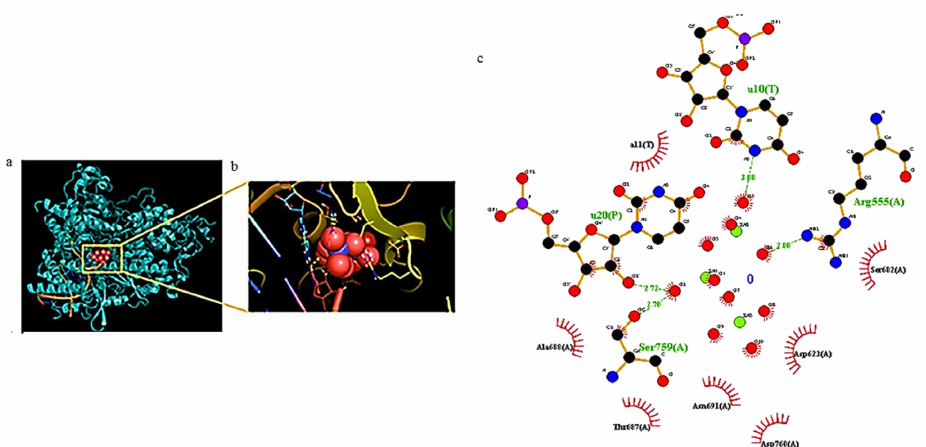
Figure 7. ( a ) Docking results of ZnO NPs interacting with amino acids of COVID-19 RdRp and ( b ) corresponding zoom. ( c ) The related ligand–protein interaction diagrams. The dashed green lines indicate hydrogen bonds. Figure reprinted from Ref. [121] under the terms of the Attribution- NonCommercial-NoDerivatives 4.0 International (CC BY-NC-ND 4.0)